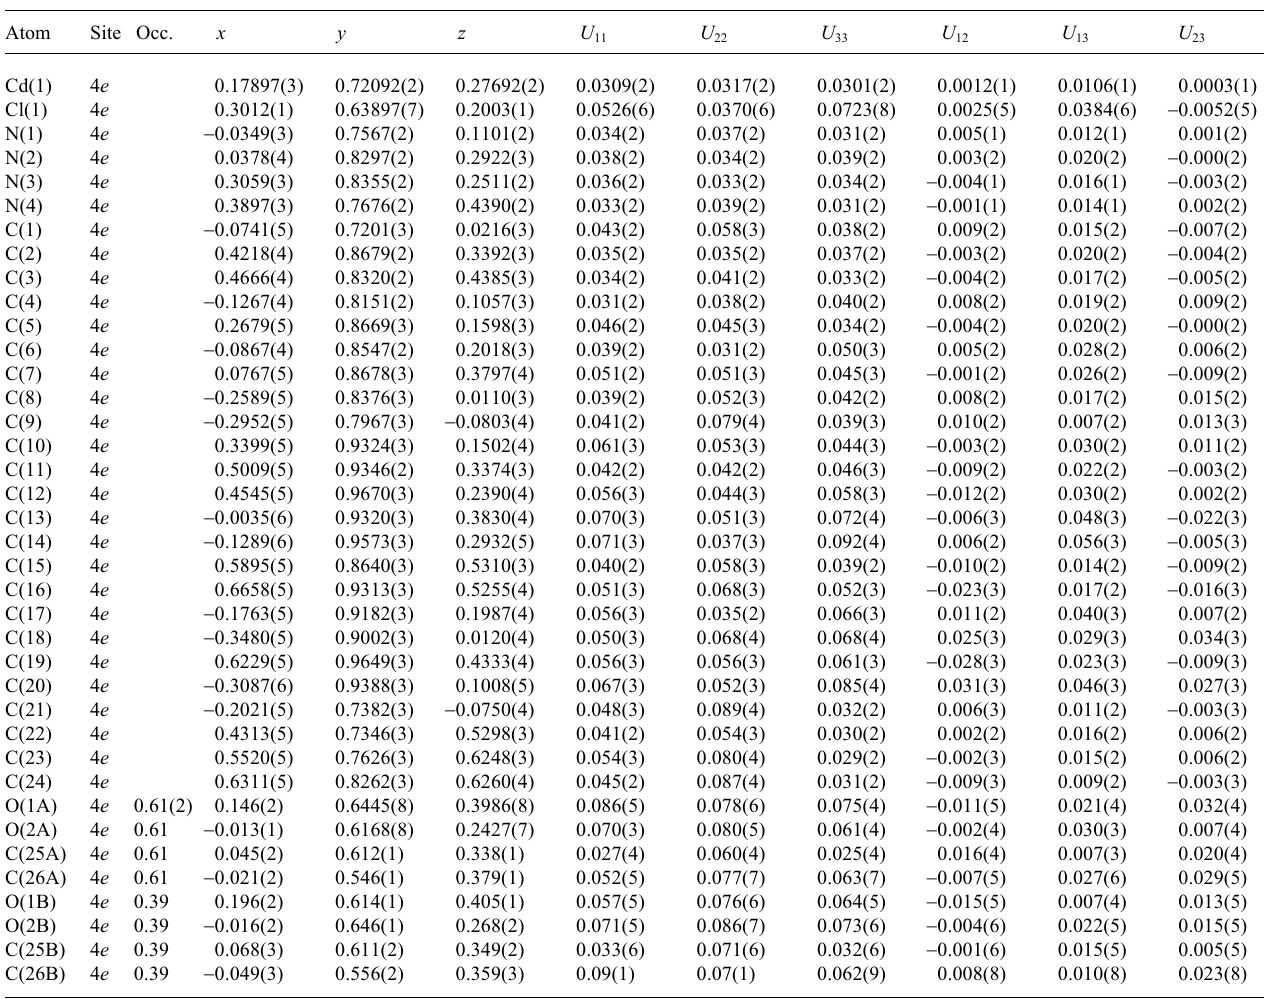
Table 3. Atomic coordinates and displacement parameters (in Å 2